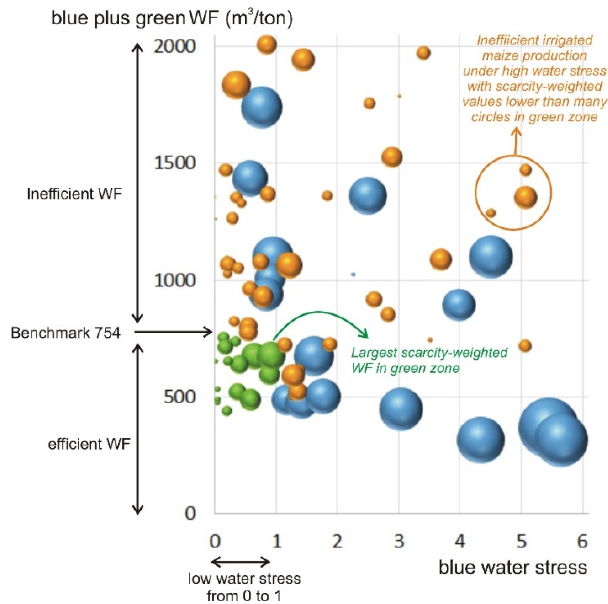
Figure 3. Relationship between (blue and green) WF of irrigated maize with blue water stress as well as a scarcity-weighted WF (relative amounts in circle size). Green circles indicate sustainable situations (low water stress and WF below a threshold / benchmark). The benchmark is chosen at 754 m 3 / t. Blue and orange circles indicate unsustainable situations (water stress is larger than 1 and / or WF above the benchmark). Orange circles identify lower scarcity-weighted WF amounts in the unsustainable zone as compared to the highest scarcity-weighted WF amount in the sustainable zone (green circles). Blue circles identify higher scarcity-weighted WF amounts.